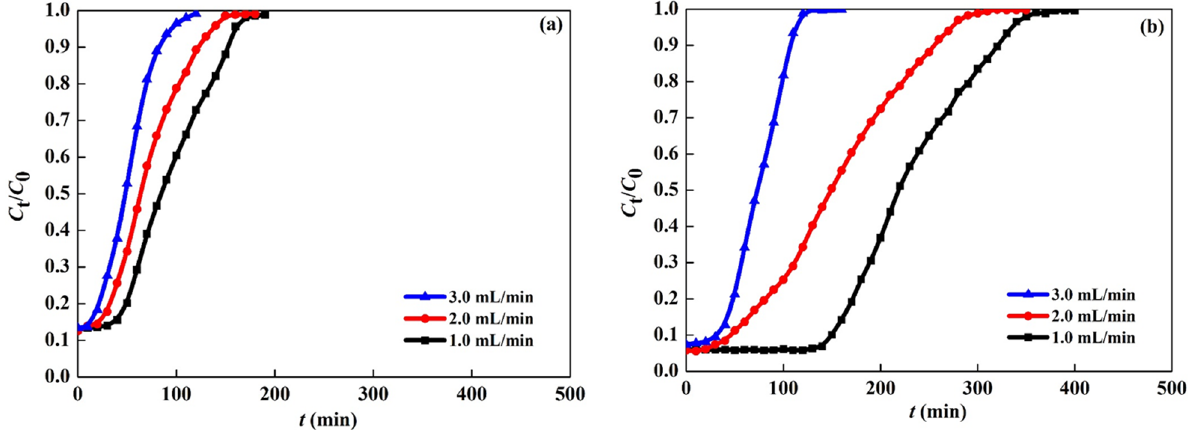
Figure 8. Effect of different flow rates on column adsorption of NAP onto O-SAC1 ( a ) and O- PCAC1 ( b ) at a concentration of 30 mg/L and column height of 1 cm.